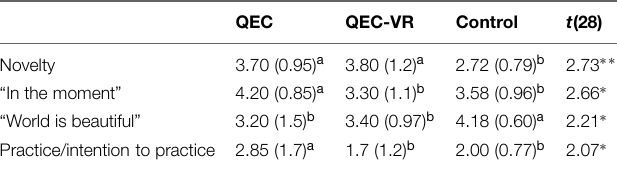
TABLE 3 | Mean (SD) scores for each group on manipulation check items.